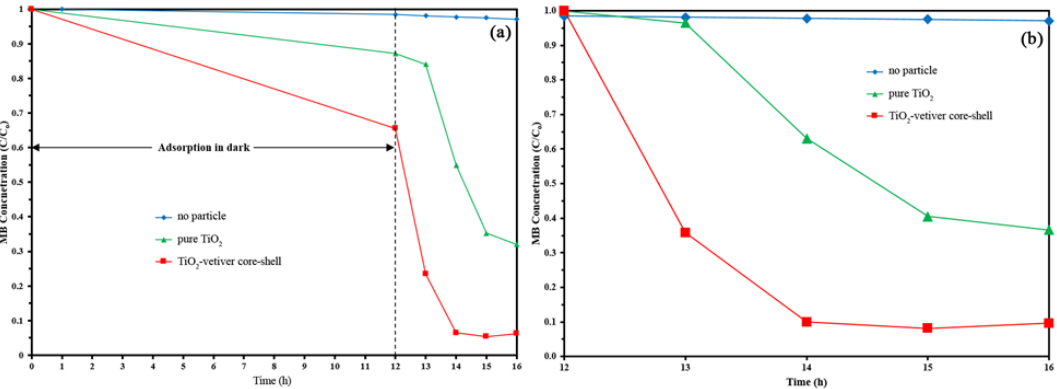
Figure 6. Photocatalytic activity of pure TiO 2 and TiO 2 -vetiver core–shells, showing ( a ) data for complete test sequence; and ( b ) data normalised following MB adsorption.